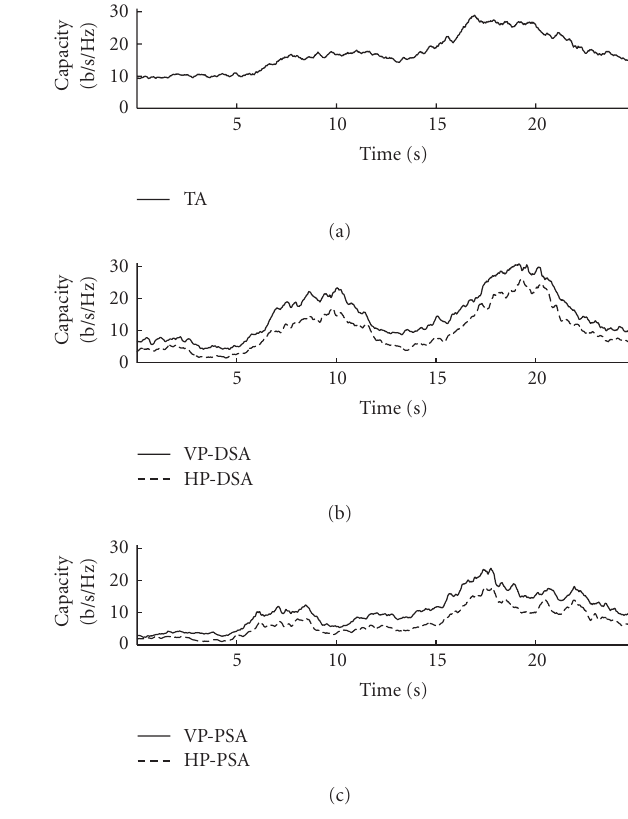
Figure 14: Capacity estimated at each array position on Slater Street.